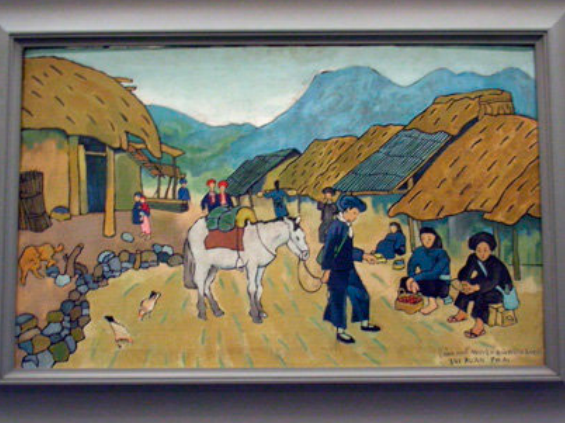
Figure A15. Canh pho Nguyen Binh —Bui Xuan Phai. Hang at Vietnam Fine Arts Museum. The images were sourced from Tuoi Tre Newspaper (Ly 2008).